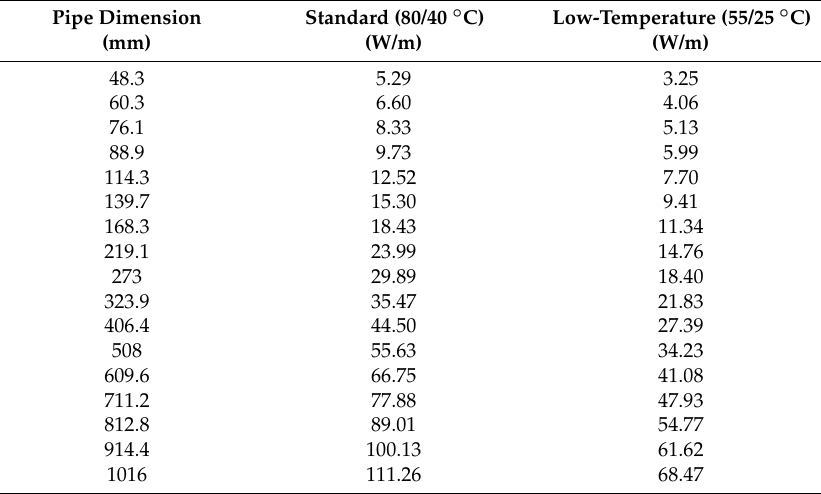
Table 4. Estimated heat losses for various dimensions of pipes.